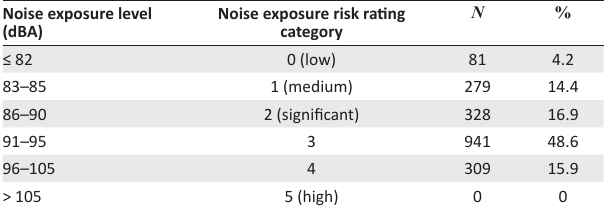
TABLE 3: Noise exposure risk rating categories of exposed miners ( N = 1963).